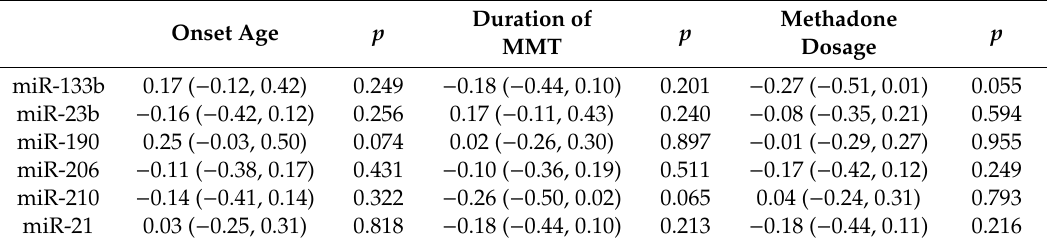
Table 2. Correlations between microRNA levels and opioid profiles of patients with opioid use